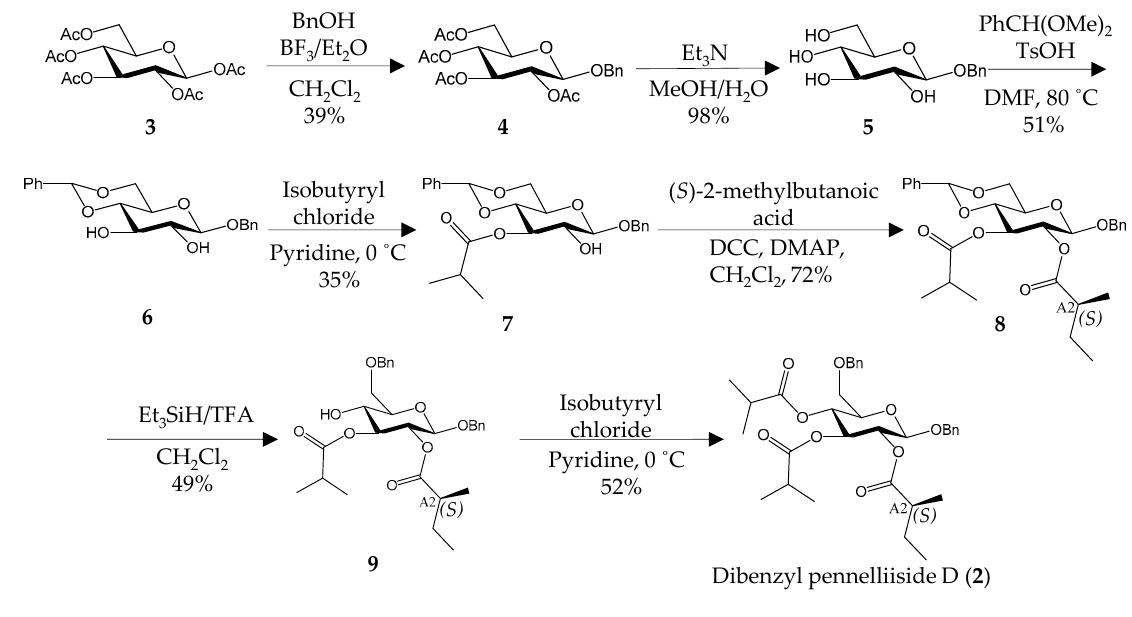
Scheme 2. Total synthesis of dibenzyl pennelliiside D ( 2 ).